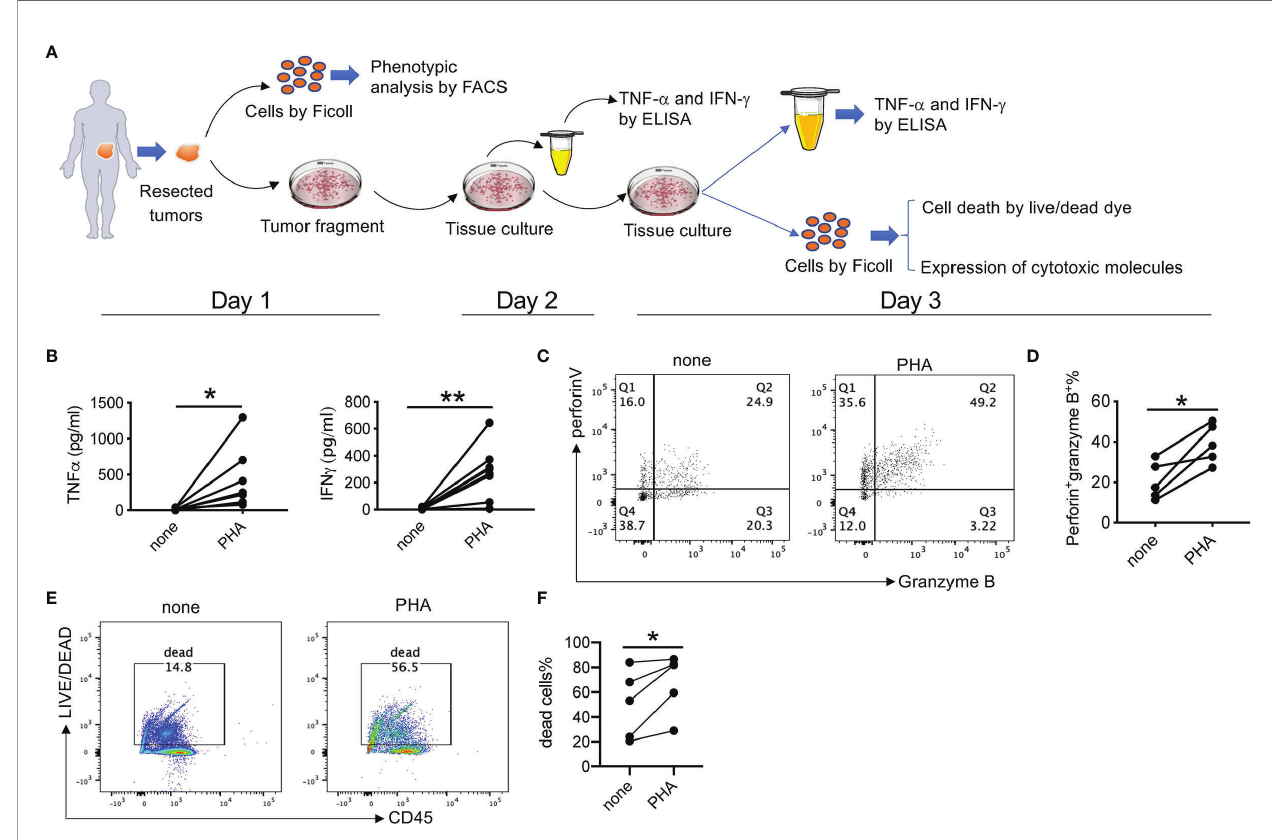
FIGURE 4 | Ex vivo culture of clear cell renal cell carcinoma (ccRCC) tissue slices. (A) Schematic overview of the ex vivo culture model. Human tumor tissue was manually processed in tissue slices with a proportion for single-cell preparation. The tumor tissue slices were placed in a 24-well plate in the presence or absence of different stimuli or inhibitors for 3 days. The culture supernatant was collected on both day 2 and day 3 for cytokine secretion. On day 3, single-cell suspension was prepared and analyzed for cell death, proliferation, and cytotoxic capacity. (B) Summarized data about TNF- a and IFN- g stimulated by phytohemagglutinin (PHA) from 8 patients. The experiment was performed in triplicate. Each line means one patient. (C) Representative fl uorescence-activated cell sorting (FACS) plot showing expression levels of perforin and granzyme B (D) Summarized data about the frequency of perforin + granzyme B + CD8 + T cells (n = 5). (E) Representative FACS plot showing percentages of dead cells. (F) Summarized data about the percentages of dead cells (n = 5). * p < 0.05, ** p <